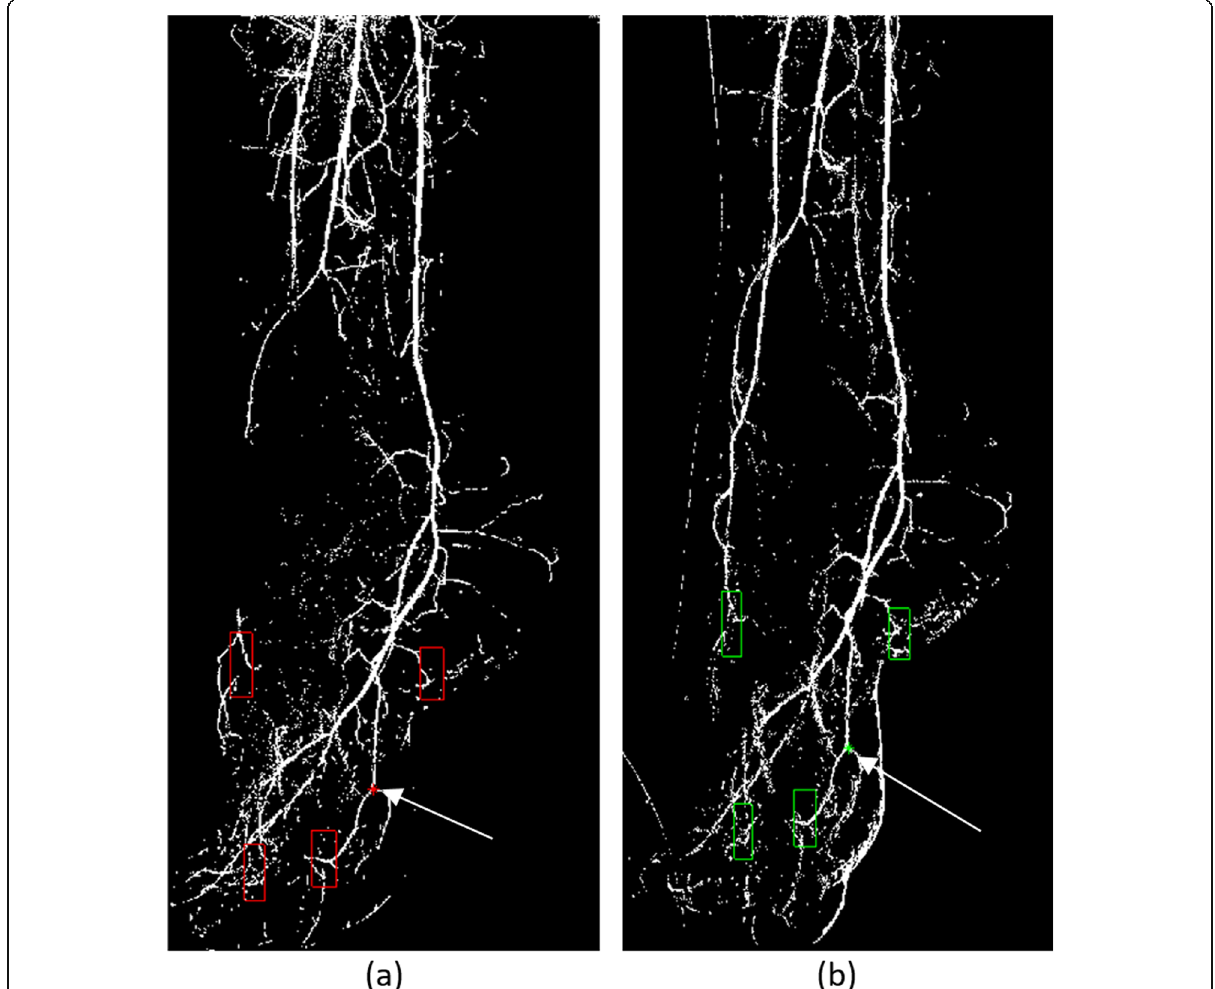
Fig. 6 Region of interest (ROI) initialization for analysis and marked registration points. a Pre-therapy with ROIs and registration point in red (arrow) and post-therapy with ROIs located by the registration procedure and registration point in green